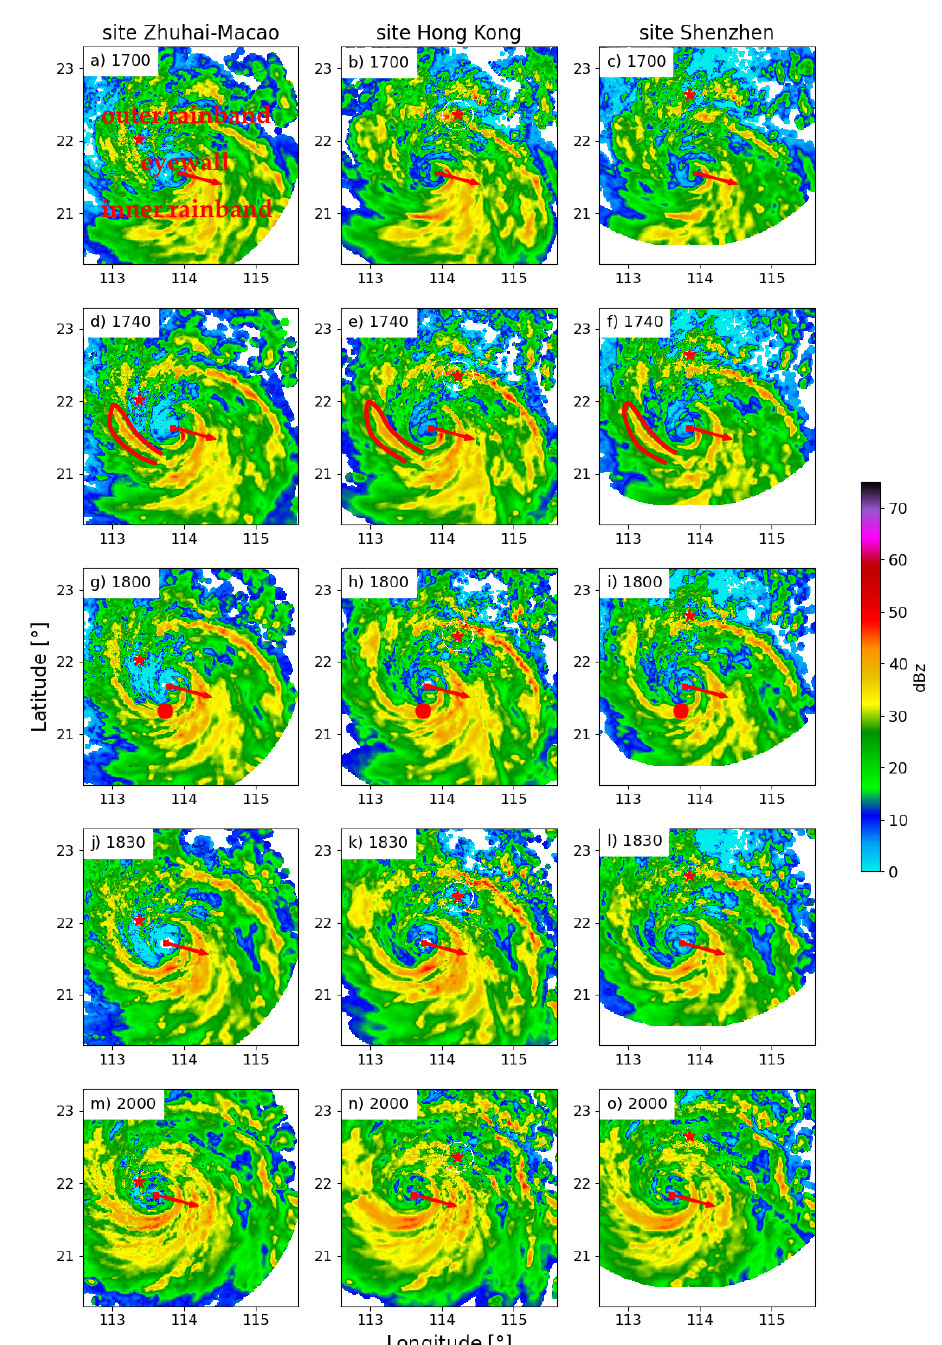
Figure 2. Reflectivity of Typhoon Higos at 3 km altitude observed by Zhuhai-Macau radar, Tate’s Cairn radar in Hong Kong and Shenzhen radar at ( a – c ) 17:00, ( d – f ) 17:40, ( g – i ) 18:00, ( j – l ) 18:30 and ( m – o ) 20:00 UTC on 18 August 2020. The red stars represent the radar locations, the red square box represents the typhoon center and the red arrow is the VWS vector of 200–850 hPa. The three red characters in ( a ) indicate the approximate location of the eyewall, inner rainband and outer rainband.